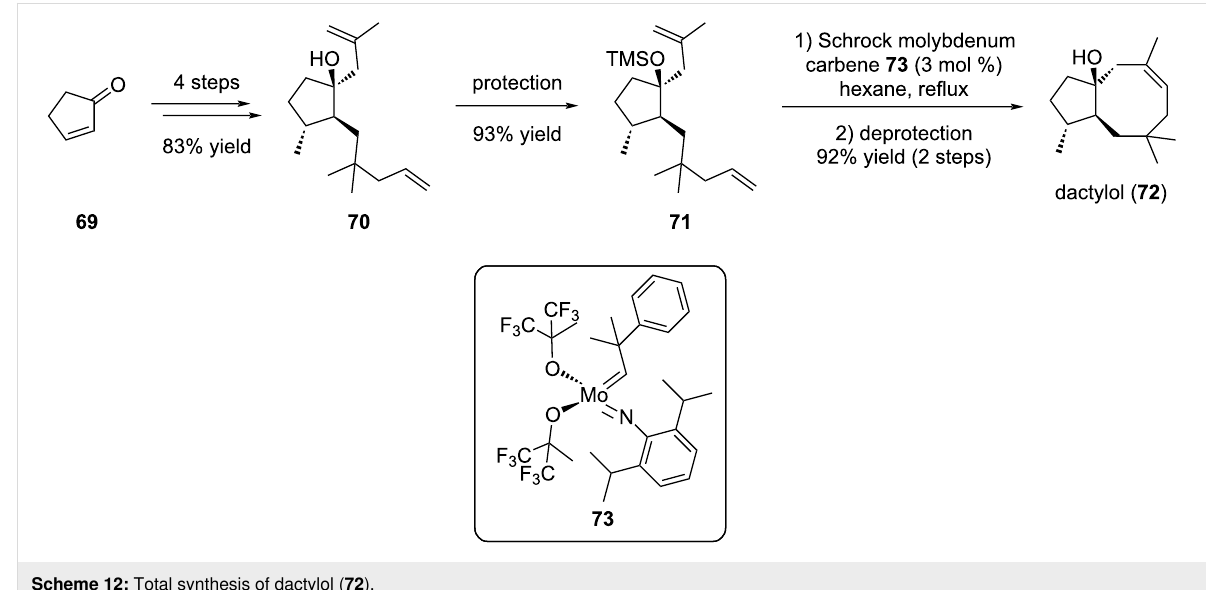
junction cycle [37,38]. In 1996, Fürstner and Langemann re- ported an efficient and short total synthesis of the natural product dactylol ( 72 ) (Scheme 12) [37]. The main originality of this work was the use of the Schrock molybdenum carbene cata- lyst 73 for the ring-closing metathesis reaction. The metathesis precursor 70 was obtained in 4 steps from commercial cyclopentenone 69 . Protection of the alcohol function was mandatory prior to the cyclization as the free alcohol substrate failed to cyclize. As proposed by the authors, interaction be- tween the free alcohol 70 and the molybdenum metal center may explain the reaction inhibition. Thus, after protection of the alcohol function as a silyl ether leading to diene 71 , the RCM was performed in refluxing hexane and dactylol ( 72 ) was isolat- ed in 17% overall yield after silyl ether removal